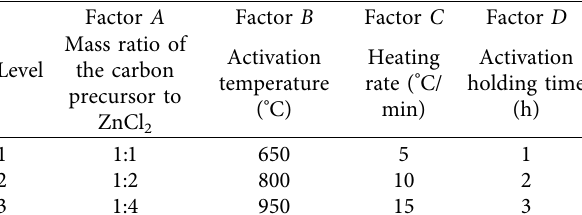
Table 4: Orthogonal factor level table L9 (3 4 ).